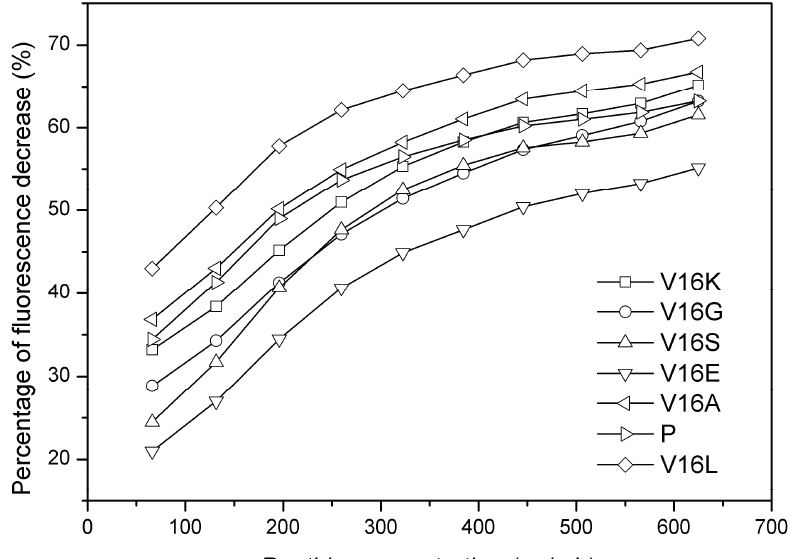
Figure 5. Differential inhibition of dansyl-polymyxin B binding to LPS by peptide